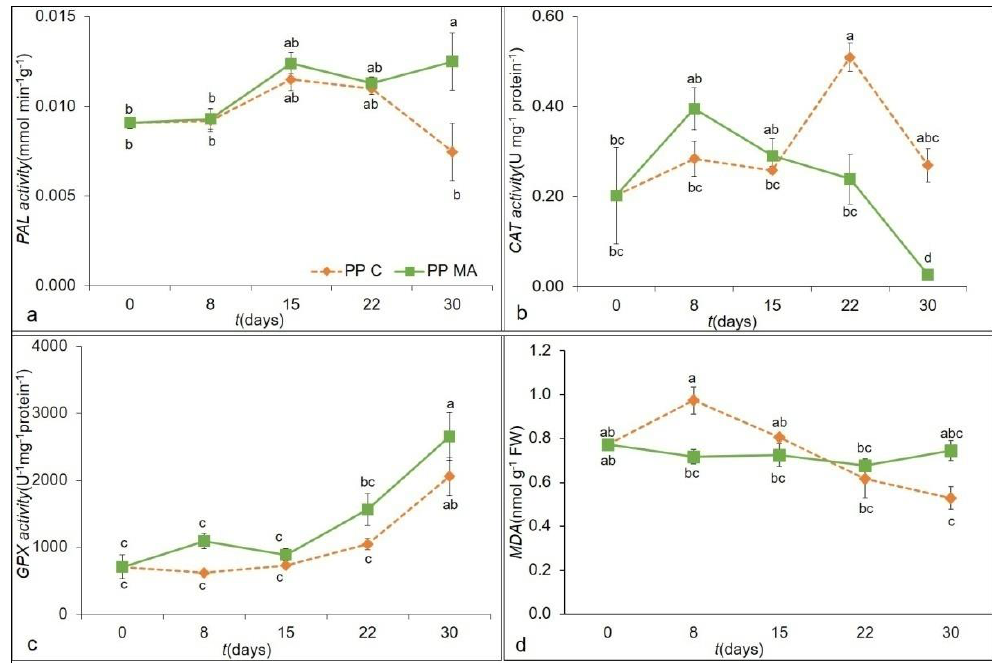
Figure 3. PAL activity (PAL) ( a ), catalase (CAT) ( b ), glutathione peroxidase (GPX) ( c ), and malondialdehyde (MDA) ( d ). as affected by the ‘packaging material × storage time’ interaction of green asparagus during 30 days of storage in PP C and PP MA. Data are the average of three replicates ± standard deviation. Means with different letters are significantly different ( p < 0.05) according to Tukey’s test.